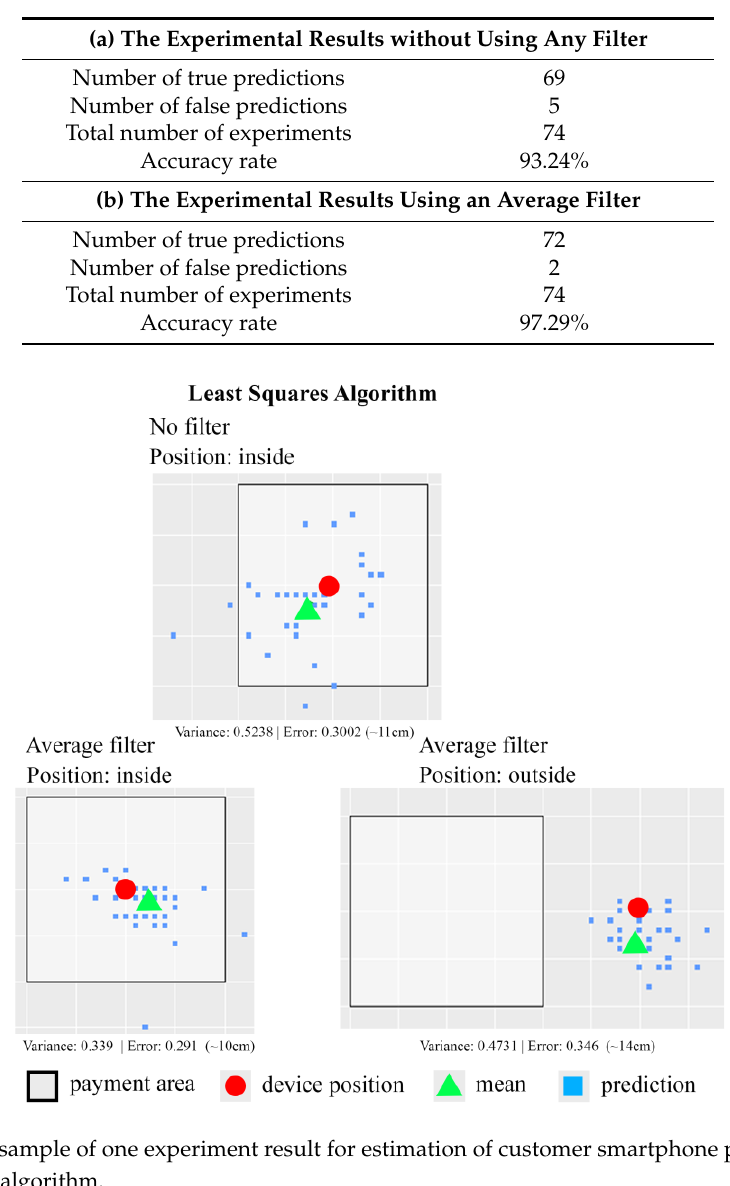
Figure 12. A sample of one experiment result for estimation of customer smartphone position using least squares algorithm.